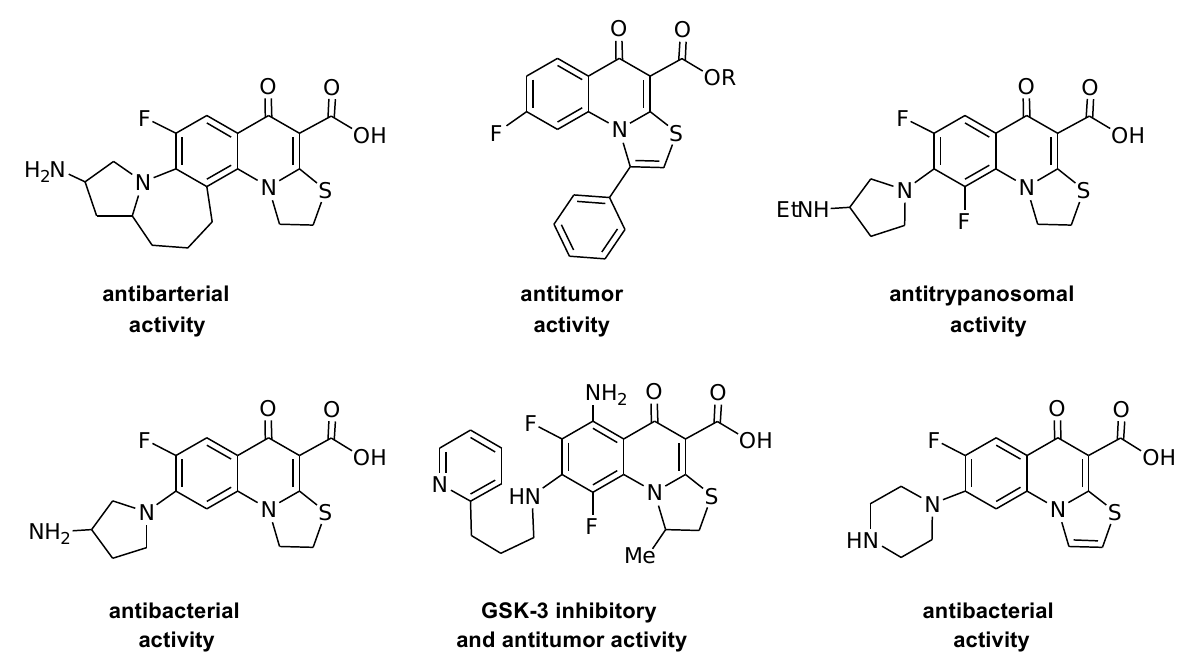
Figure 1. Known biologically active compounds containing [1,3]thiazolo[3,2- a ]quinolin-10-ium scaffold (antibacterial [11,16,21], antitumor [22,24], antitrypanosomal [26] and glycogen synthase kinase 3 inhibitor [24] activities).